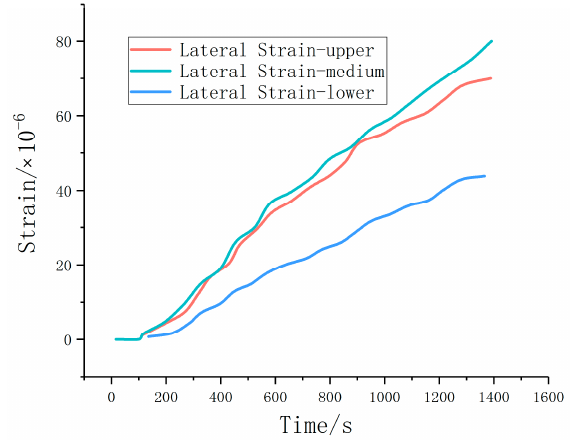
Figure 8. Stress-strain curves of flexible material backfilling body.